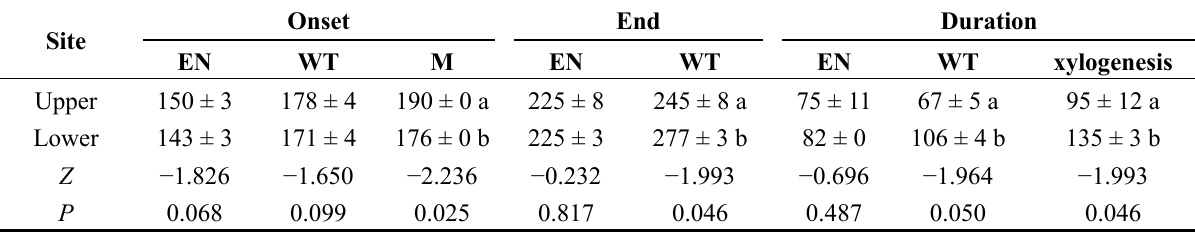
Table 2. Timing and duration of xylem differentiation and cell production at the upper and lower distribution limits of Larix principis-rupprechtii trees in the